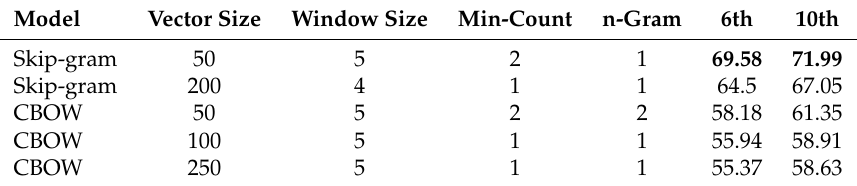
Table 2. Accuracies of the first ten instances without training in Domain 2 of the model using LSTM as a controller. The best result is archived by using feature vectors generated from word2vec in the skip-gram model with the following parameters: n-gram of 1, vector-size of 50, window-size of 5, min-count of 2.